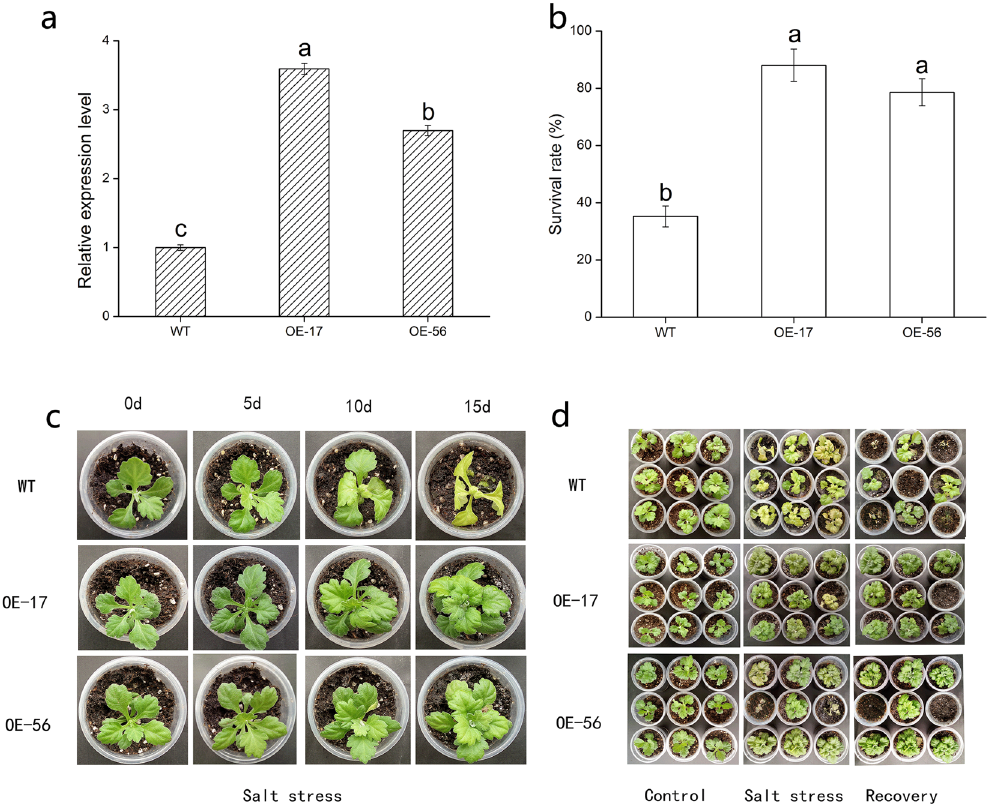
Figure 2. Salinity tolerance of transgenic chrysanthemum plants overexpressing DgWRKY5 (OE-17 and OE- 56). ( a ) The expression level of DgWRKY5 in wild type (WT) and transgenic lines. ( b ) The survival rates of transgenic lines and WT after two weeks of recoveries. ( c ) Phenotypic comparison of DgWRKY5 transgenic lines (OE-17 and OE-56) and WT under salt stress. ( d ) Transgenic lines and WT grown under non-stress and salt stress conditions, followed by a